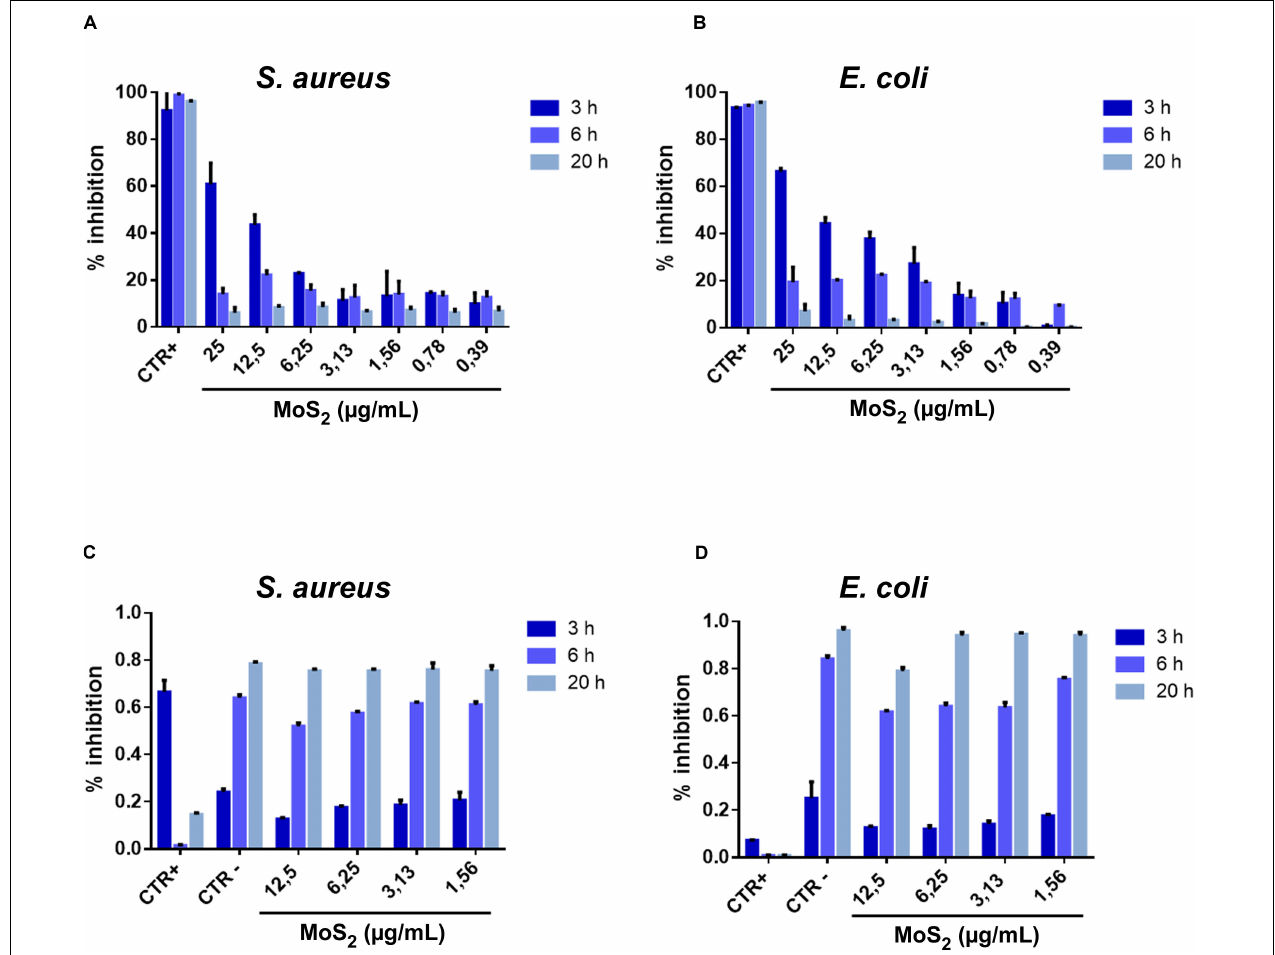
FIGURE 2 | Percentage of bacterial growth inhibition after treatment with MoS 2 NSs. (A,B) Histograms related to S. aureus (A) and E. coli (B) illustrate the antibacterial property of MoS 2 NSs after interaction for 3, 6, and 20 h at various incubated concentrations. (C,D) Bacteria viability as measured by the optical density of the target at 600 nm ( OD 600) for different MoS 2 NSs concentrations after interaction for 3, 6, and 20 h. (C) For S. aureus and (D) for E. coli. Ampicillin and vancomycin represented the positive controls for E. coli and S. aureus , respectively. The negative controls were consisted of deionized water. The data statistical error is standard deviation of three independent experiments. P -value is less than